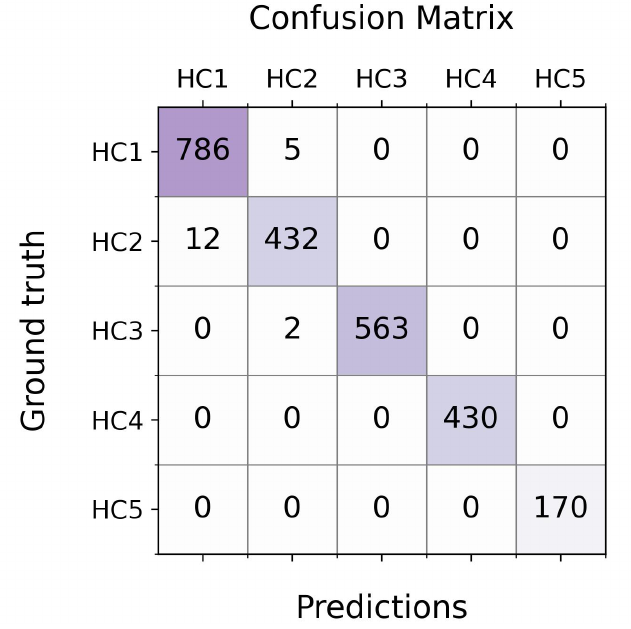
Figure 9. Confusion matrix of object detection for the validation